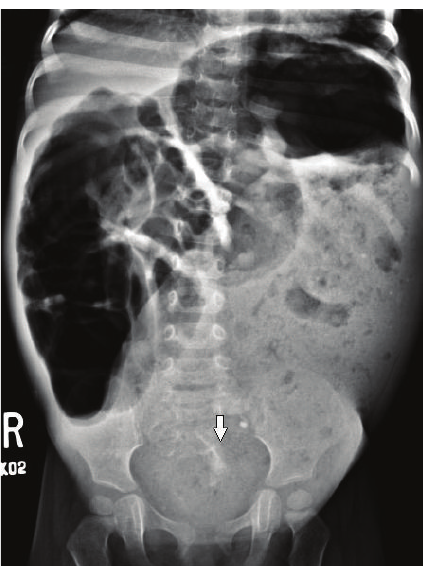
Figure 1: Abdominal radiograph for abdominal distention evalu- ation. It shows significantly dilated air and fecal filled bowel loops with fecaliths. There is a sickle-shaped sacral defect (arrow), not reported